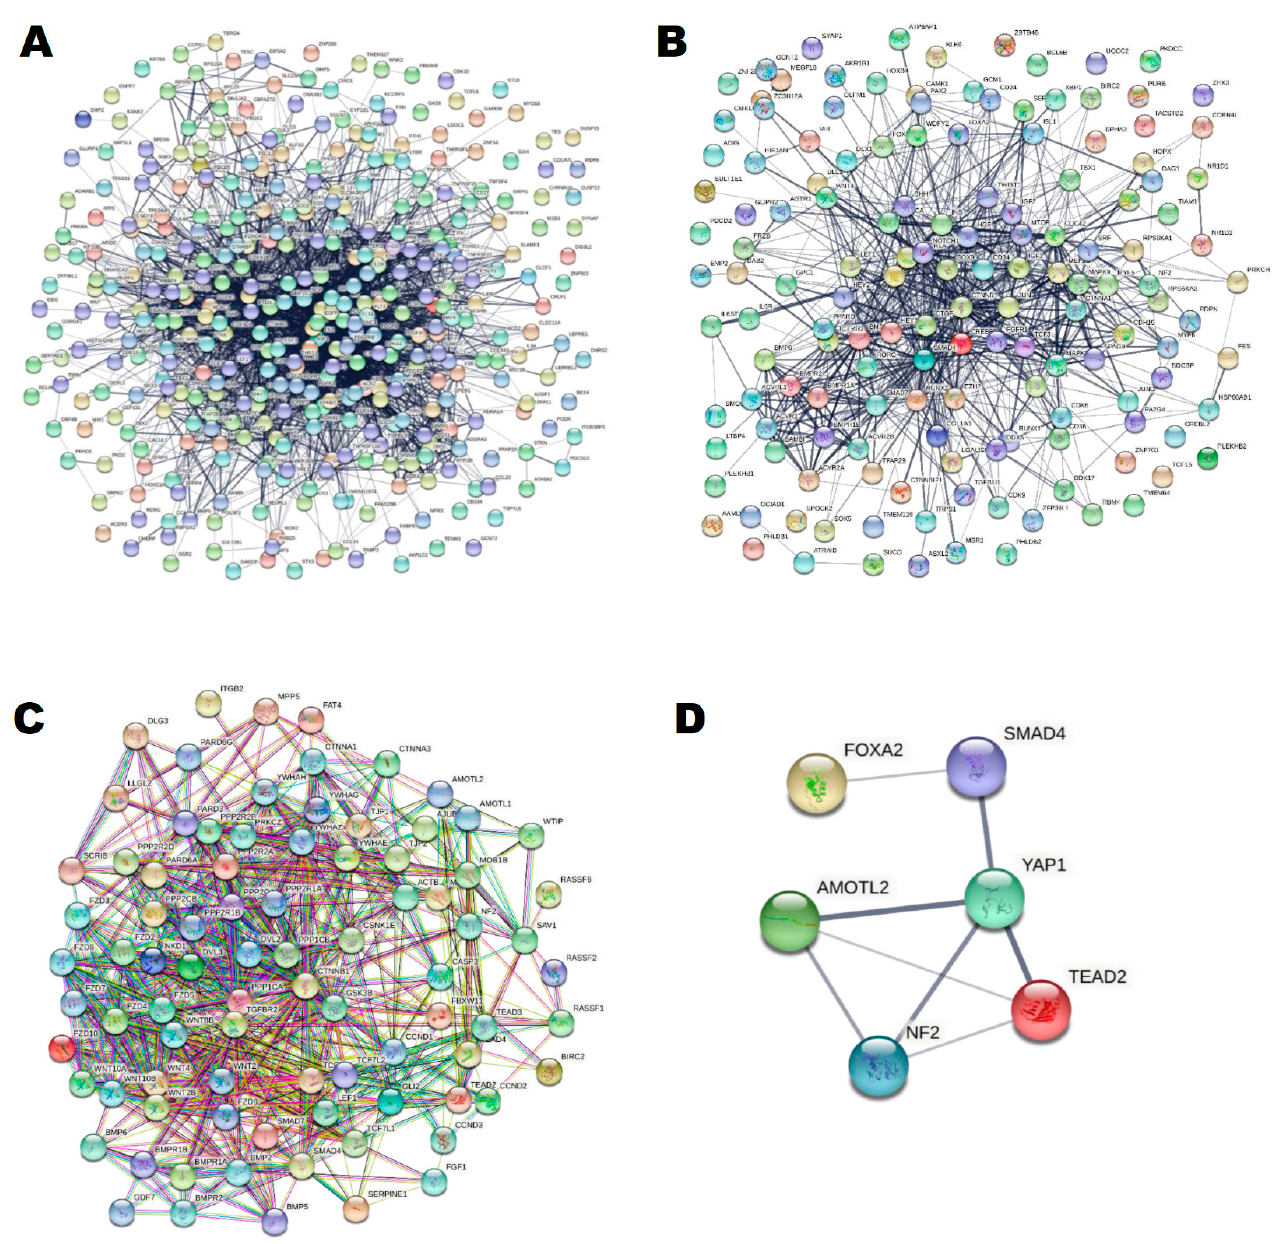
Figure 2. The protein–protein interaction networks that were obtained by using String tool. ( A ) DEGs in cell proliferation gene set. ( B ) DEGs in cell differentiation gene set. ( C ) DEGs in Hippo pathway gene set. ( D ) The filtered selected key hub genes. (http://stringdb.org; version 11.0, accessed on 22 April 2021).